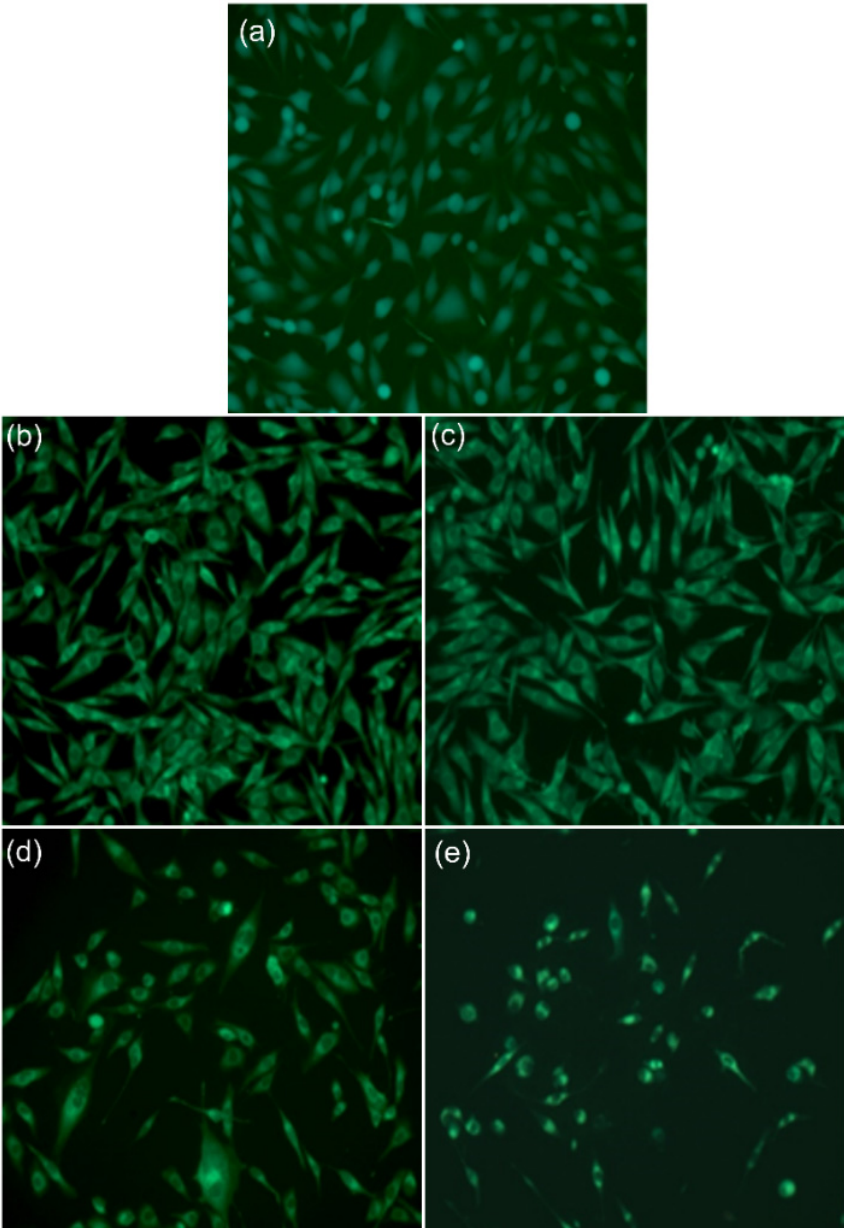
Figure 6. The morphology of MG63 cells grown on coated materials: control ( a ), Si ( b ), HApCh ( c ), 8MgHApCh ( d ), 30MgHApCh ( e ) (Fluorescence, Objective 20×). Flow cytometry analysis of cells grown in the presence of the MgHApCh composite layers showed that, in the presence of Mg, there was a slight increase in the number of cells found in the synthesis (S) phase and a more significant reduction in the number of cells in G2/M in the case of the highest Mg concentration (x Mg = 0.3) (Figure 7). All these results supported the toxicity induced by the presence of Mg.